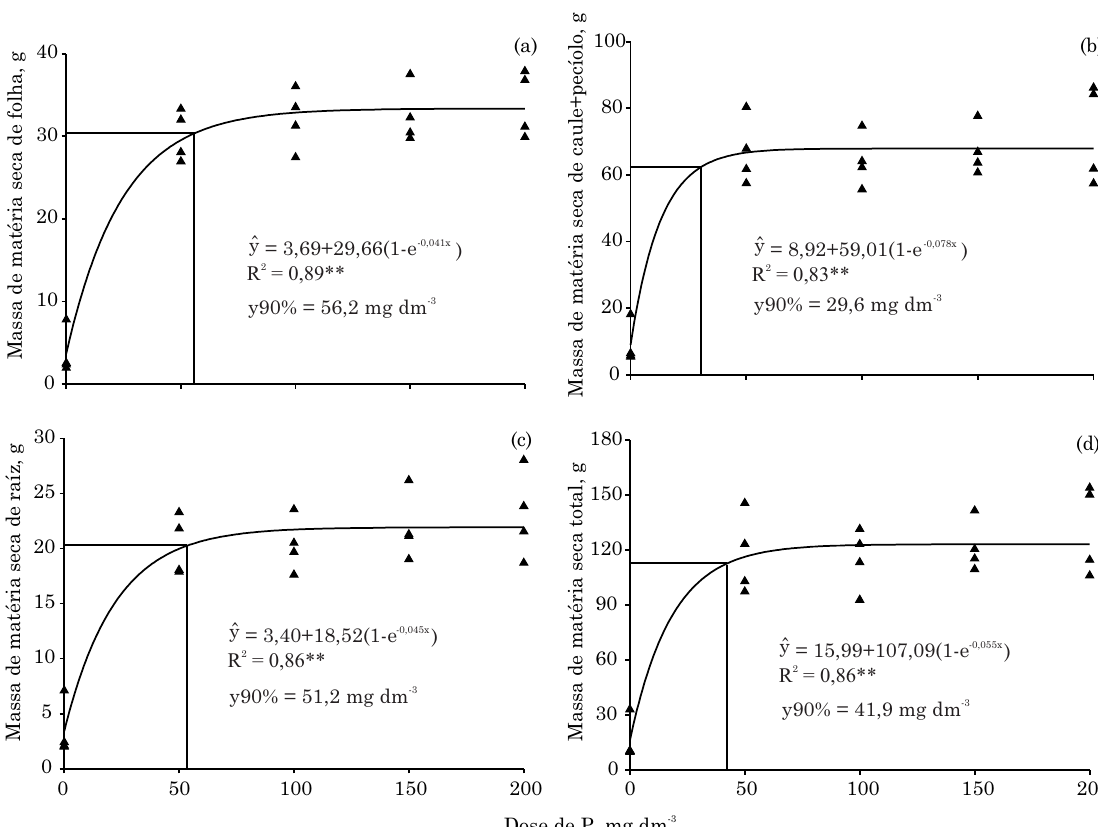
Figura 3. Massa de matéria seca de folhas (a), de caule+pecíolo (b), de raízes (c) e total (d) de plantas de pinhão-manso em função de doses de fósforo, 150 dias após o transplantio. ** significativo a 1